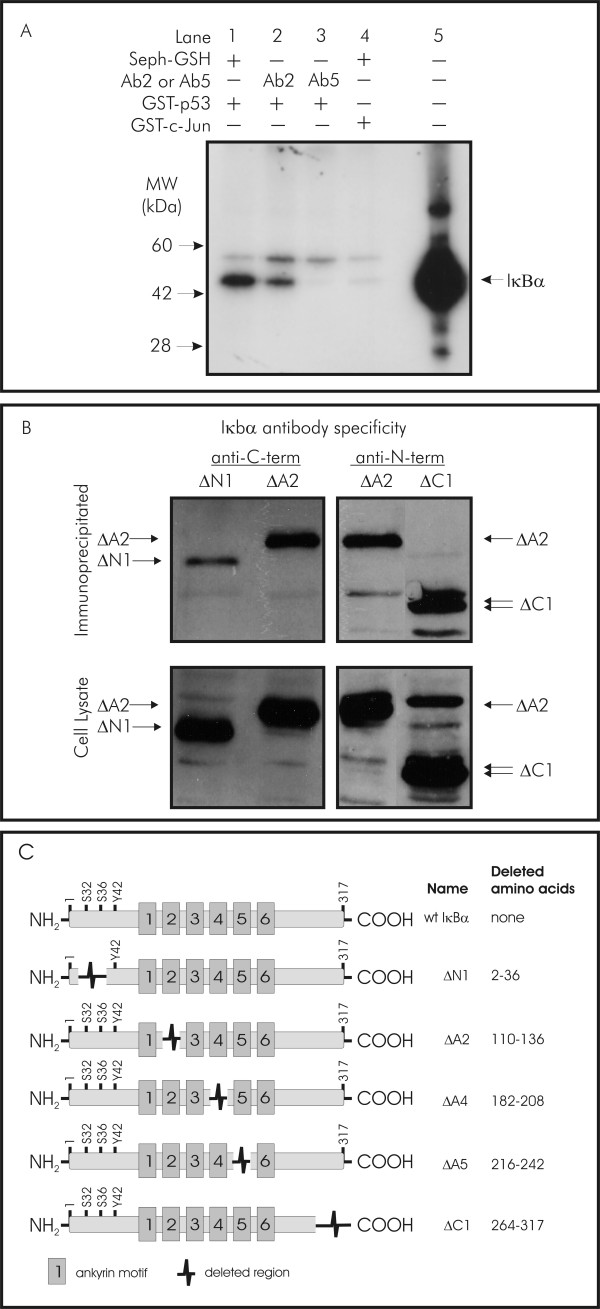
P53 and IκBα proteins co-precipitate in vitro. A: Purified bacterially produced IκBα protein co-precipitated specifically with p53. Purified IκBα protein was specifically labeled with [γ-32P]ATP using p90rsk (lane 5). [32P]-labeled IκBα was incubated with purified p53 (GST-p53, lanes 1–3) or a control GST fusion protein (GST-c-Jun, lane 4). P53 was precipitated either by a glutathione binding tag on GST-p53 and glutathione Sepharose beads (Seph-GSH, lane 1) or a p53 specific antibody (Ab2, lane 2) and protein A/G Sephadex beads. IκBα protein (position indicated) was not precipitated by p53 specific Ab5 (lane 3) that does not recognize bacterially synthesized p53 protein, or by incubation with GST-c-Jun and precipitation with glutathione Sepharose beads (lane 4). Proteins were separated by PAGE and detected by autoradiography of [32P]-labeled protein. Electrophoresis of the input IκBα used in this experiment is also shown in lane 5. B: Relatively less ΔN1 protein than ΔC1 IκBα protein co-precipitated with GST-p53 from COS cell lysates. After expression of IκBα in COS cells, whole cell lysates were incubated with bacterially produced purified p53 (GST-p53). P53/ IκBα complexes were then precipitated with glutathione Sepharose beads and analyzed by PAGE/Western blotting. In the left panels, ΔN1 and ΔA2 proteins were detected using a rabbit polyclonal antisera directed at the C-terminus of IκBα, while in the right panels, ΔA2 and ΔC1 proteins were detected using a rabbit polyclonal antisera directed at the N-terminus of IκBα. C: Structures of wild-type IκBα and mutant constructs used in these studies.